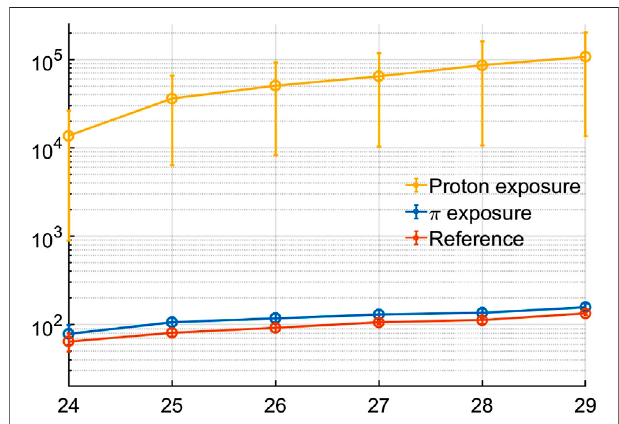
FIGURE 9 | Radiation hardness experimental results (mean values on four devices). DCRtrendsover various excessbiasvoltages arereported. The reference with no irradiation ( orange ) is compared with the noise level after 100 MeVprotonirradiation( yellow ),andwiththesamplesafter1 weekof 180 GeV/c pions